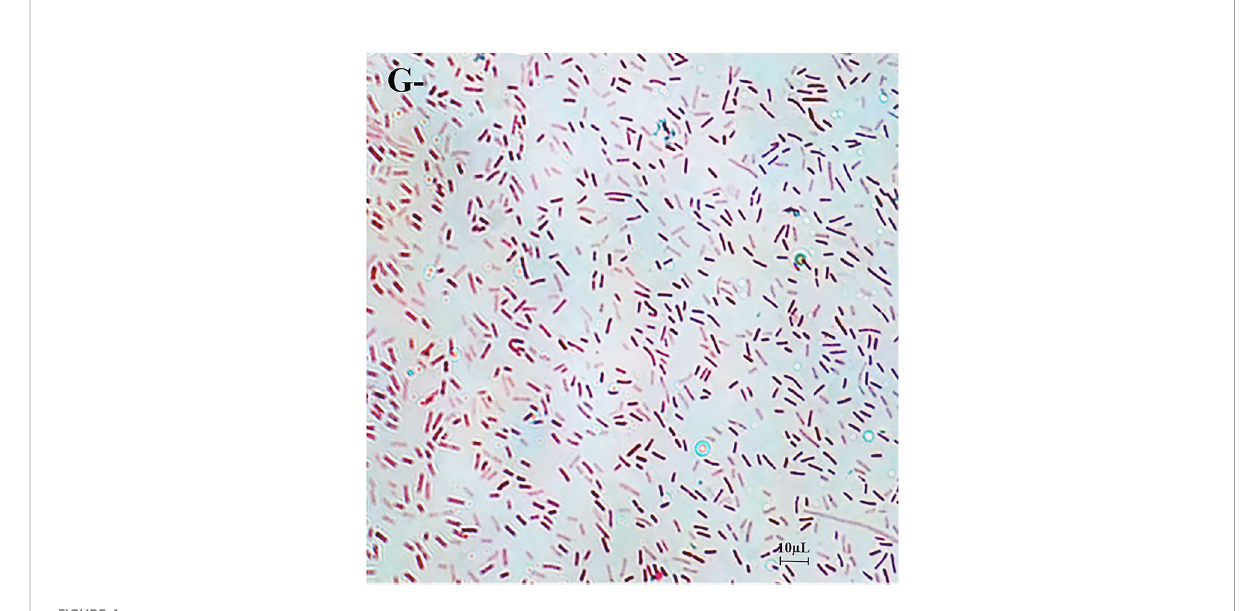
FIGURE 4 The gram stain. Gram stain shows negative, short rod-shaped bacteria. The scale used in the Figure is 10 m